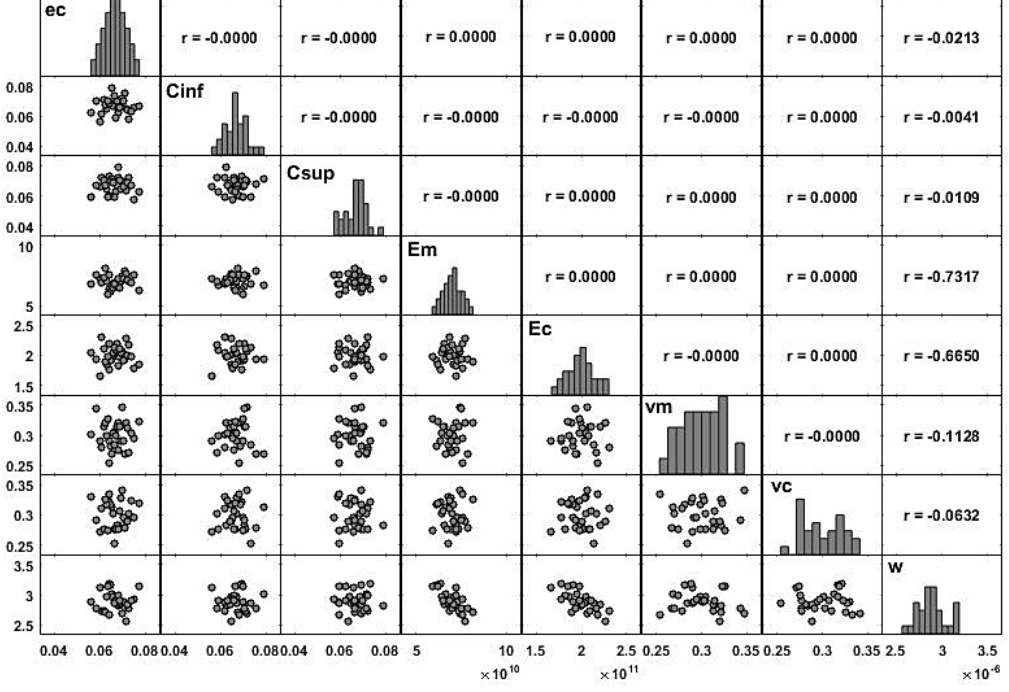
Table 8. Regression statistic: case 3.2.2 — Thinner core. LMR3